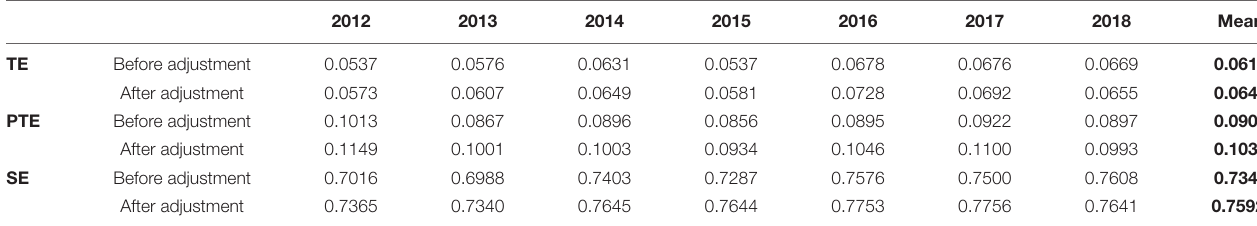
FIGURE 2 | Comparison chart of the four major sub-sectors (before and after the adjustment). TABLE 8 | Change of technical efficiency value after adjustment in